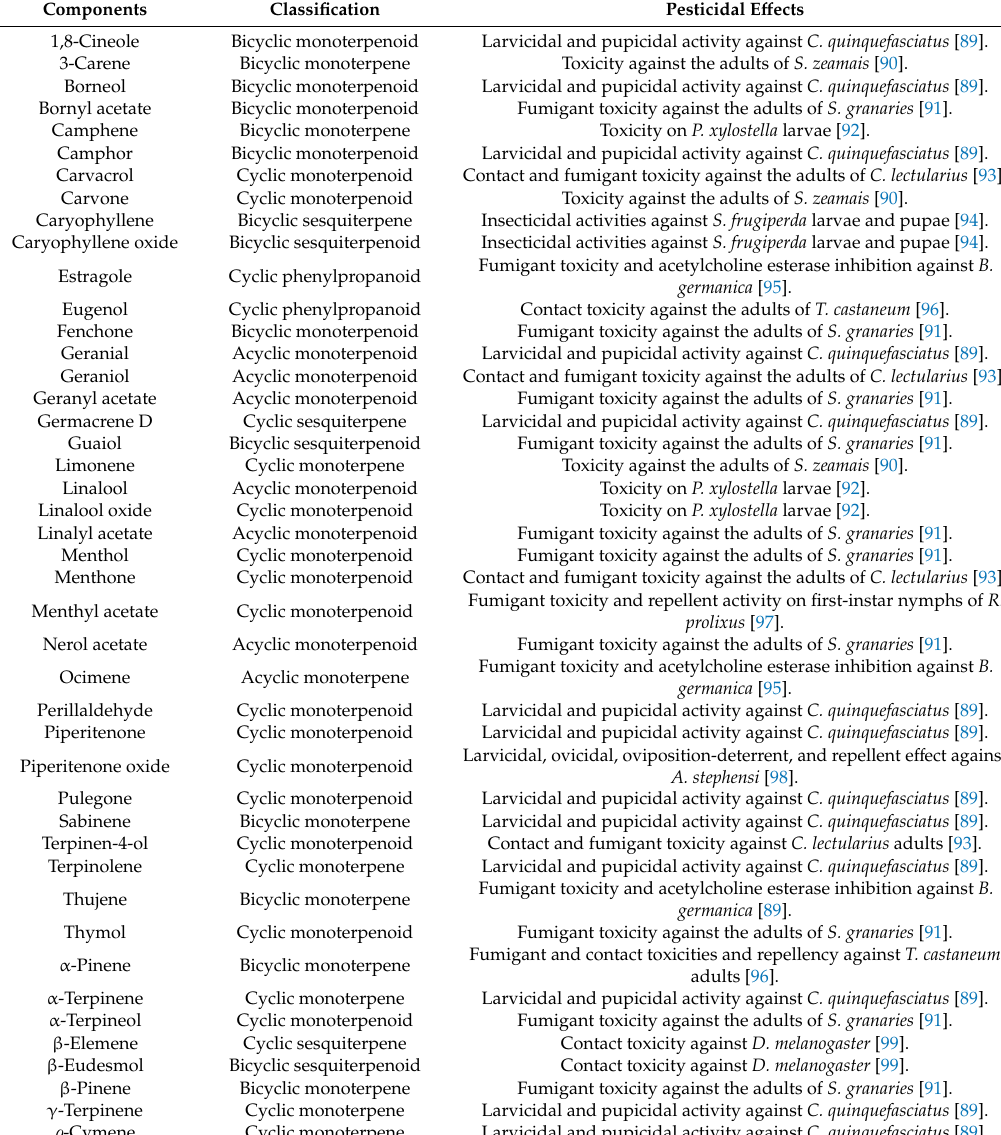
Table 3. Classification and pesticidal e ff ects of main components reported in the essential oils of the Lamiaceae plant